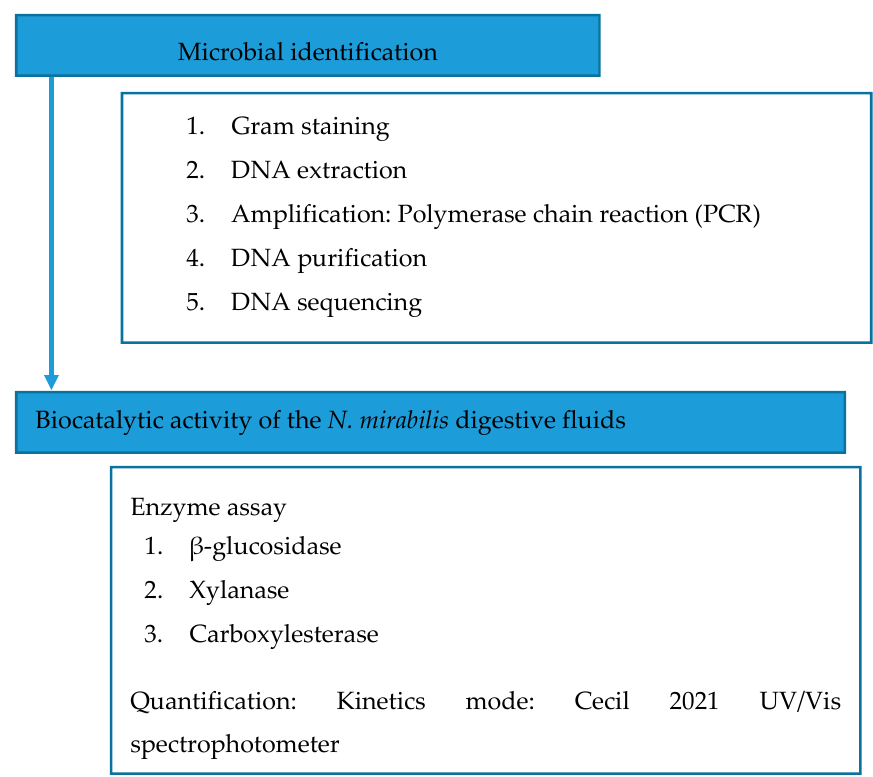
Figure 1. A schematic flow diagram of the microbial population identification and biocatalytic activity of the Nepenthes mirabilis digestive fluids.